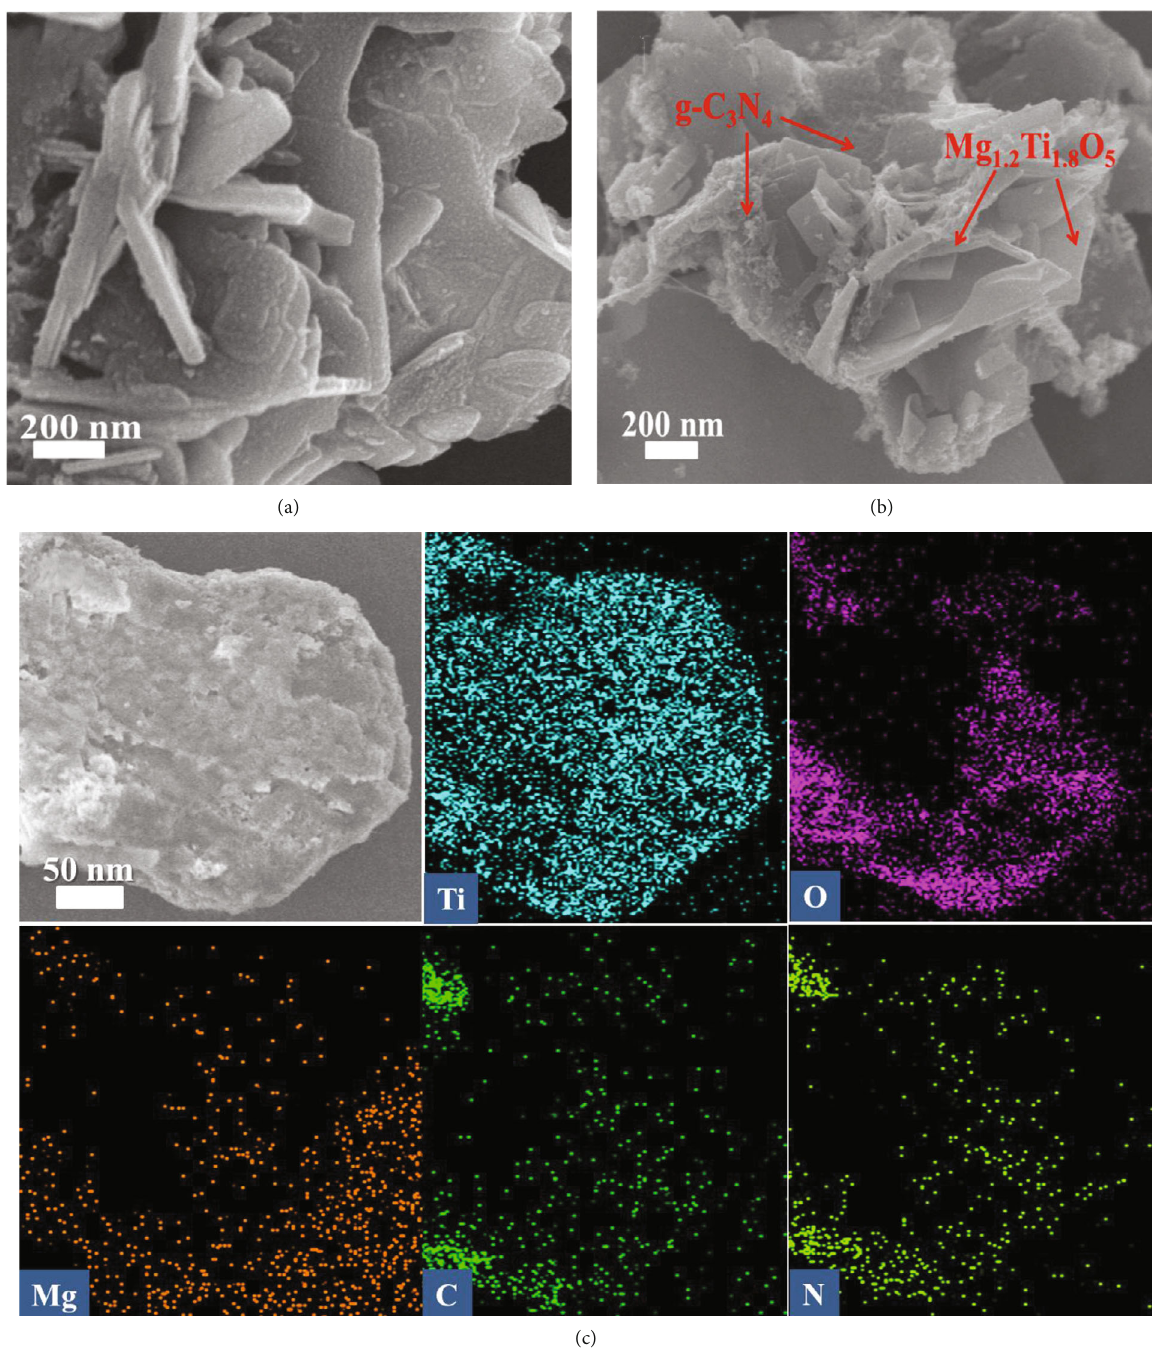
Figure 2: (a) FE-SEM images of pure MT. (b) MT/CN heterojunction. (c) SEM-EDS element mapping analysis of the MT/CN